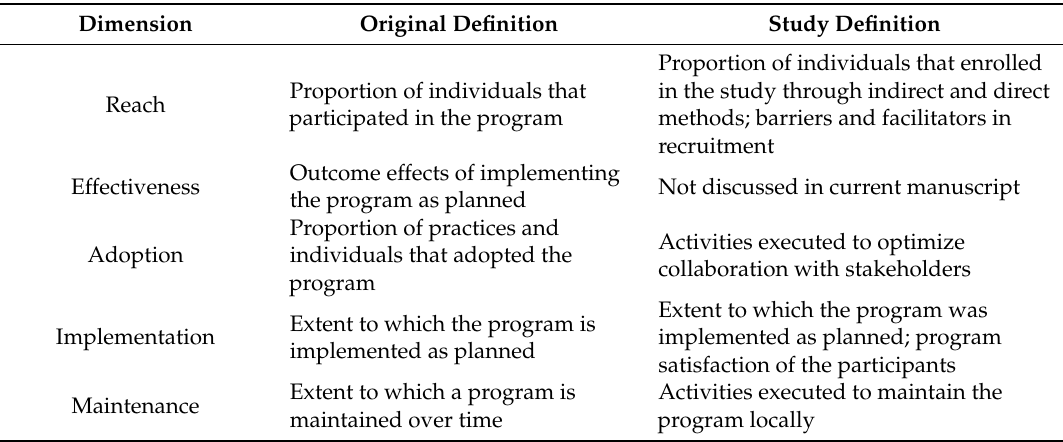
Original definitions of RE-AIM dimensions: reach, adoption, implementation, and maintenance [21], and definitions of current